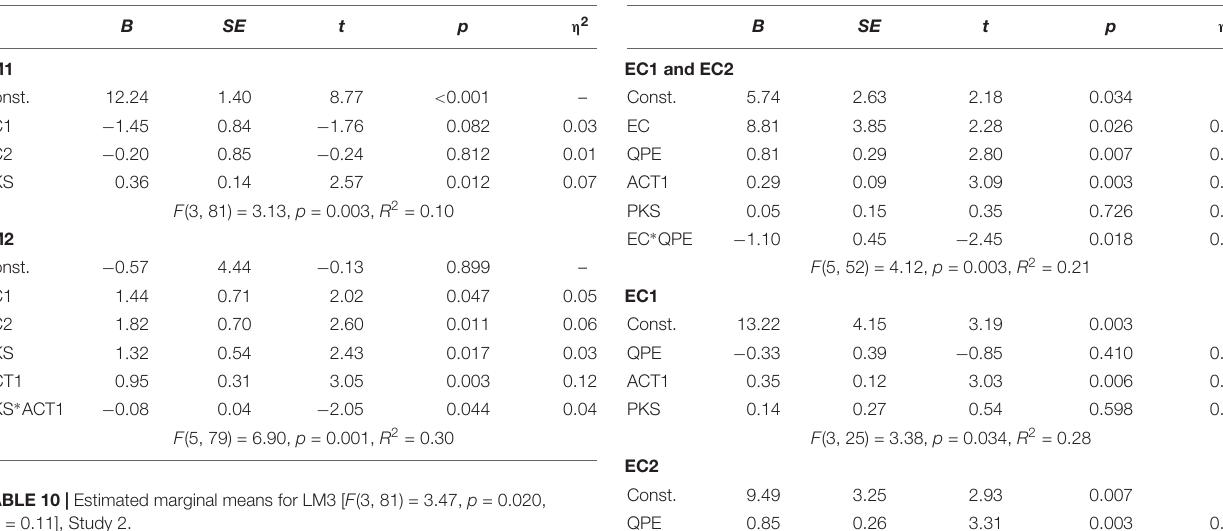
TABLE 11 | Regression results for LM4, Study